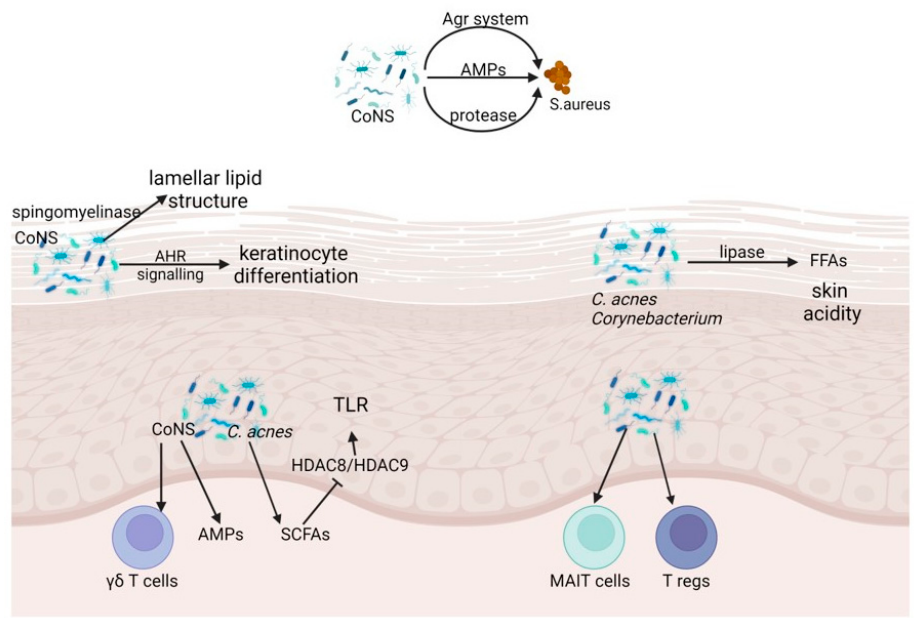
Figure 1. Microbial, physical, chemical, and innate and adaptive immune barrier function of skin microbiome. CoNS, Coagulase negative Staphylococcus ; Agr, auxiliary gene regulator; AMPs, antimicrobial peptides; AHR, aryl hydrocarbonate receptor; C. acnes , Cutibacterium acnes ; SCFA, short-chain fatty acids; HDAC, histone deacetylases; MAIT, Mucosal-associated invariant T; T regs, regulatory T cells.